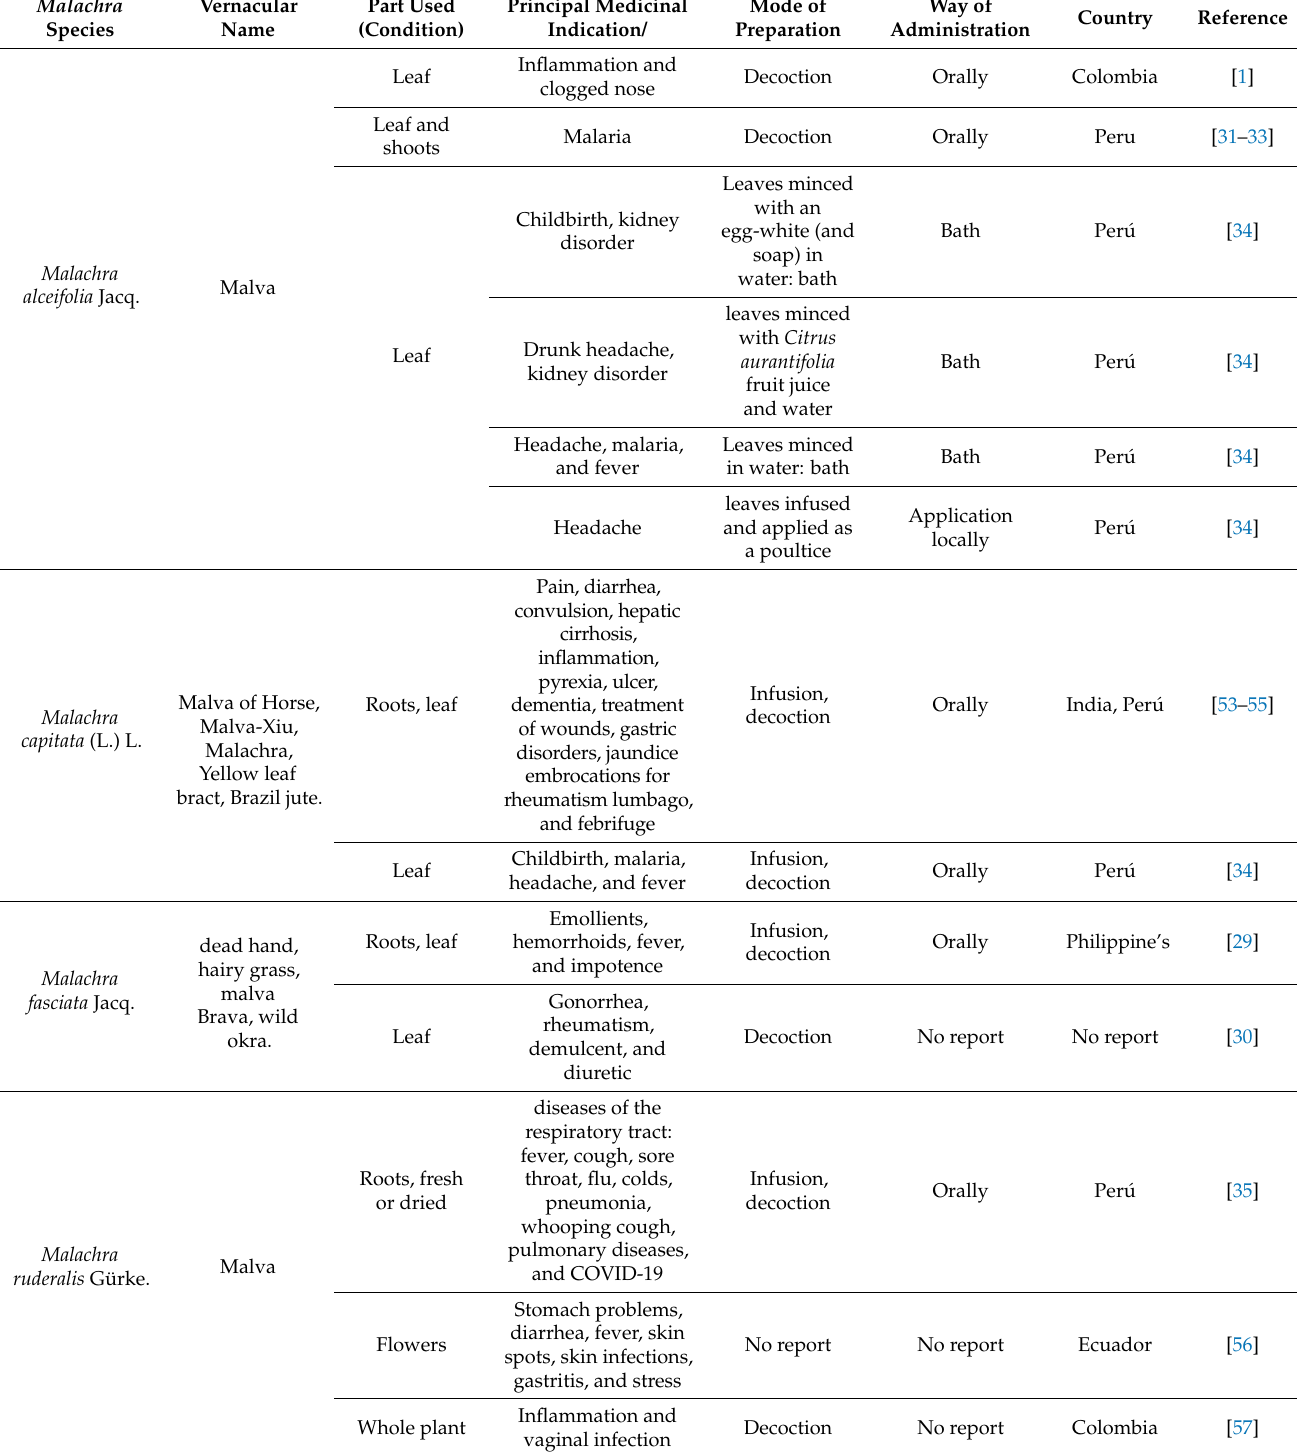
Table 5. Summary of the species of the genus Malachra L. with reported medicinal